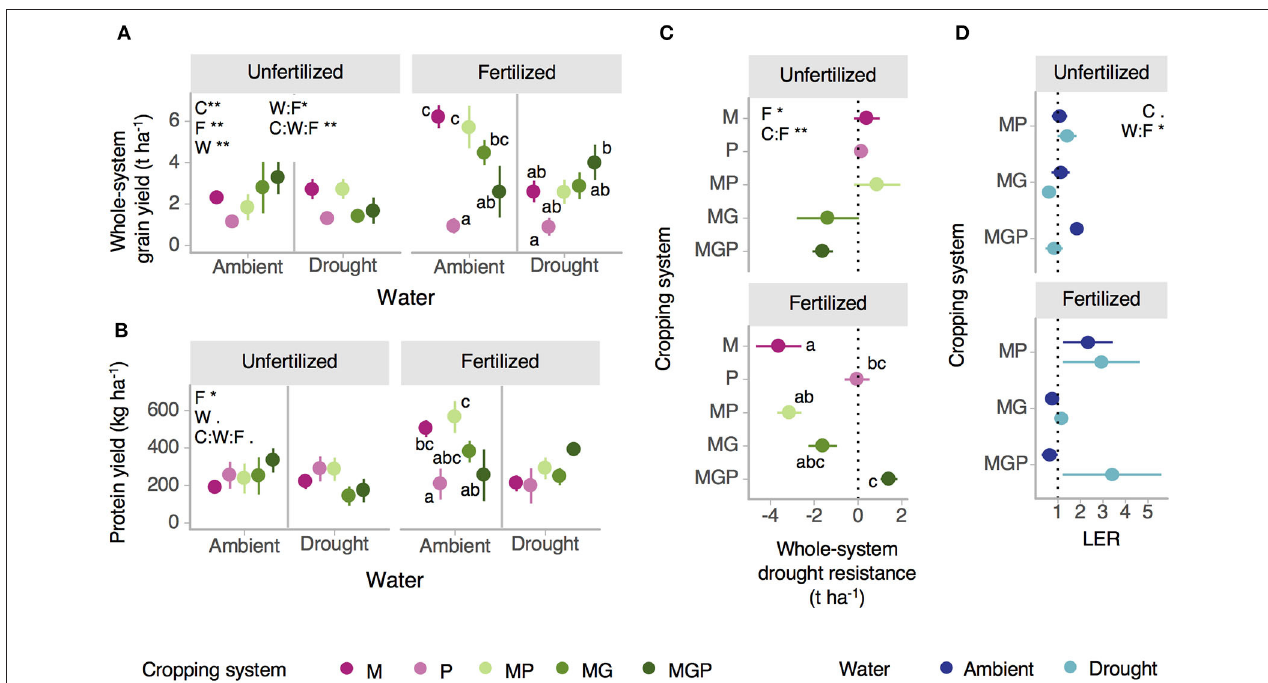
FIGURE 4 | Effects of water, cropping system, and fertilization on (A) whole-system system dry grain yield and (B) whole-system protein yield (see Supplementary Figure 5 for whole-system caloric yield). (C) Effects of cropping system and fertilization on whole-system yield drought resistance; dotted lines indicate high drought resistance (zero change due to drought) (see Supplementary Figure 5 for drought resistance of caloric and protein yield). (D) Land equivalent ratio (LER) for grain crops (maize, pigeonpea) in all intercropping systems under drought and ambient rainfall conditions with and without fertilizer. Dotted line indicates LER = 1, above which intercropping is more efficient than its corresponding monocultures in crop production per unit area. Cropping system abbreviations: M, Maize; P, Pigeonpea; MP, Maize-pigeonpea; MG, Maize-gliricidia; MGP, Maize-gliricidia-pigeonpea. Treatment factor abbreviations: W, Water; C, Cropping system; F, Fertilization. Asterisks indicate significance of treatment effects (** p < 0.01, * p < 0.05. < 0.1). Means sharing the same letter are not significantly different within a panel of a graph (alpha = 0.05). Error bars = standard error; n = 3 (fertilized MGP n =